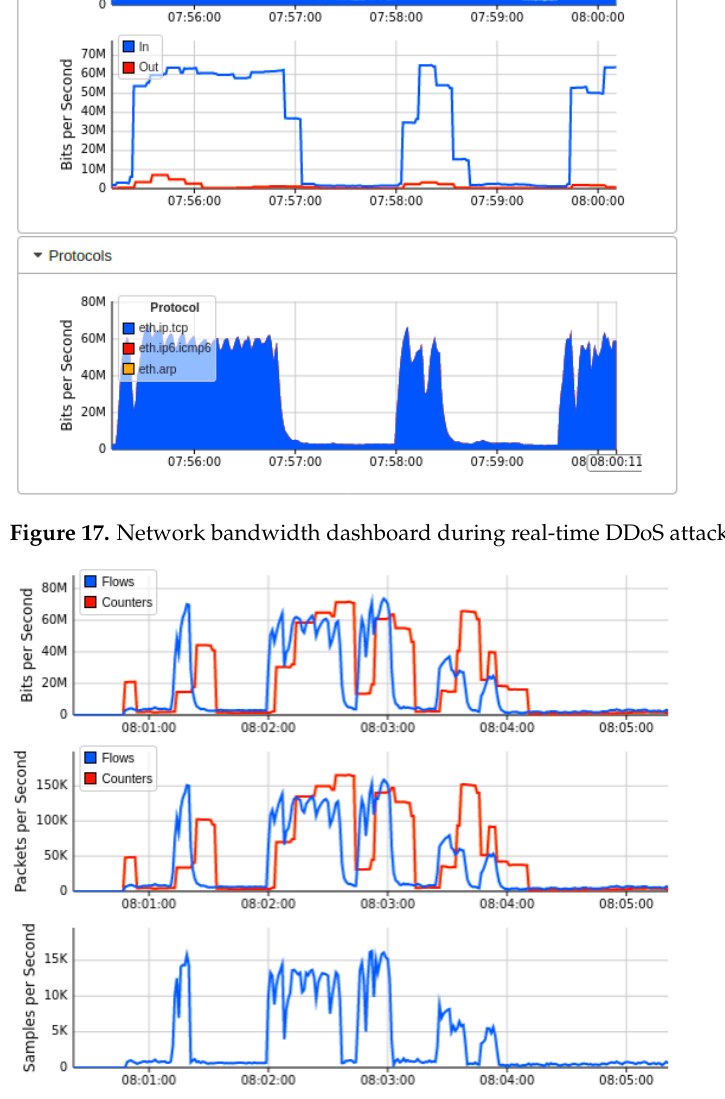
Figure 18. Performance dashboard for OF switches during DDoS attacks